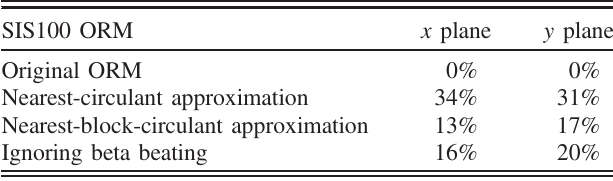
TABLE I. Calculated first iteration residuals in the case of symmetry exploitation in the SIS100